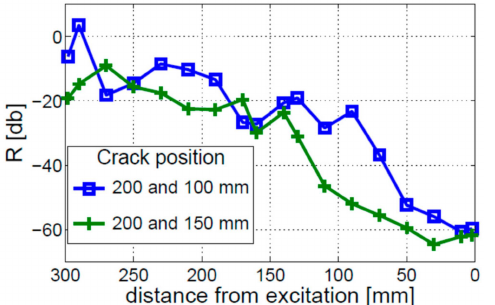
Figure 9. Crack localization effect for two different double-crack scenarios. Numerical simulations performed for the bi-linear crack model.